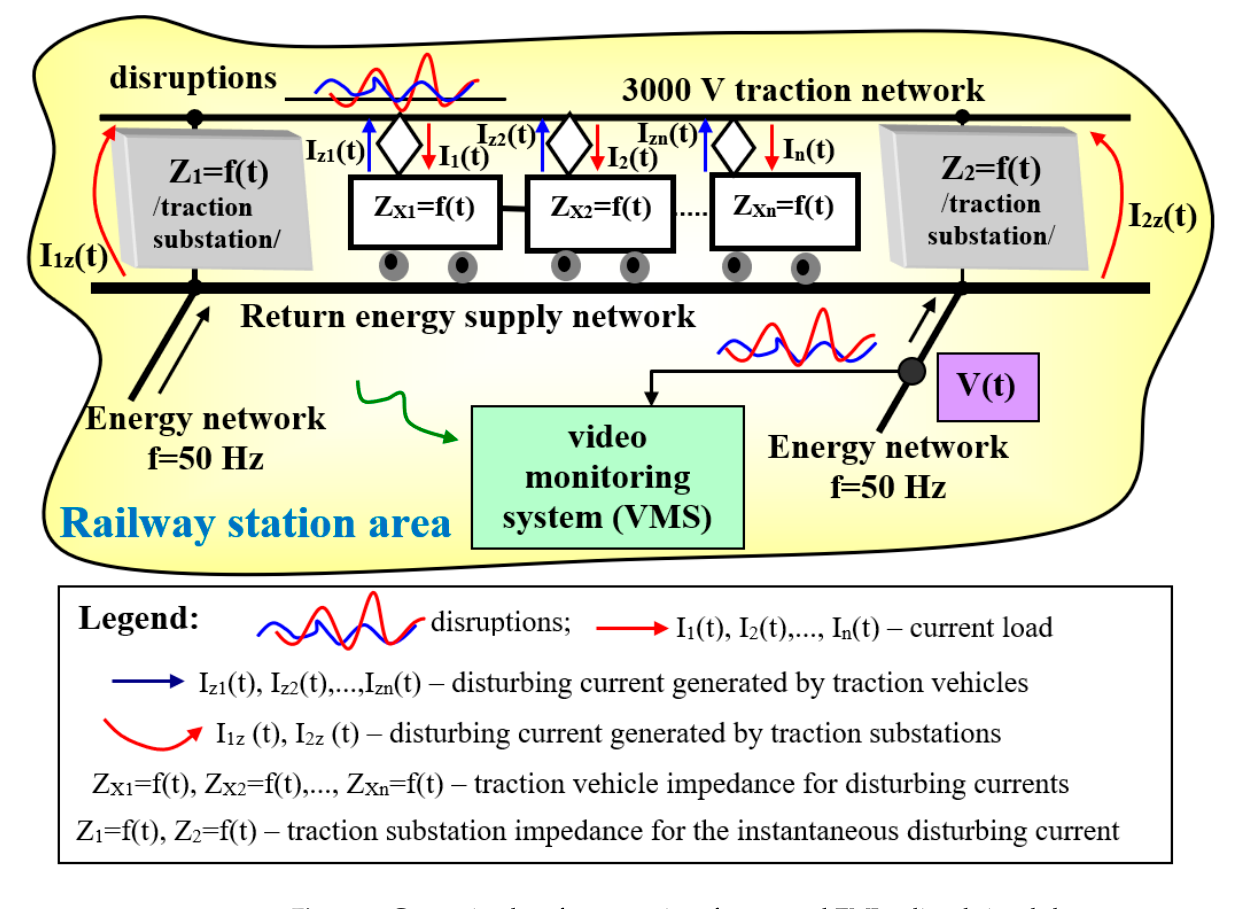
Figure 3. Generating low-frequency interference and EMI radiated signals by current consumers (traction vehicles) and overhead contact line power supply substations over a vast railway area. The most important issues related to the position of the measurement stand and the lack of external environmental impact [82–85] on measurement accuracy